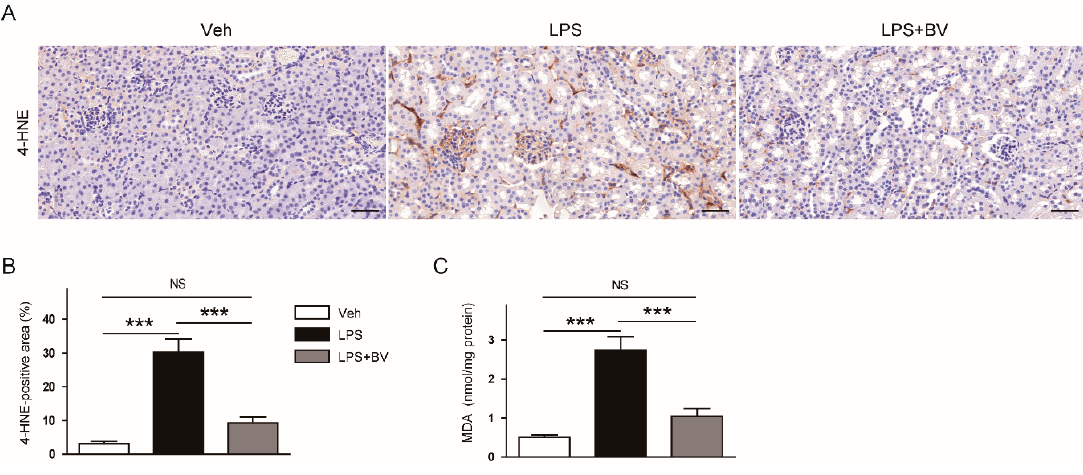
Figure 6. Bee venom attenuated oxidative stress in LPS-treated mice. ( A ) IHC staining of kidney sections using an antibody against 4-hydroxynonenal (4-HNE). Bar = 100 µ m. ( B ) Percentage of 4-HNE-positive area per field. ( C ) Renal levels of malondialdehyde (MDA). n = 8 per group. *** p < 0.001. NS, not significant.